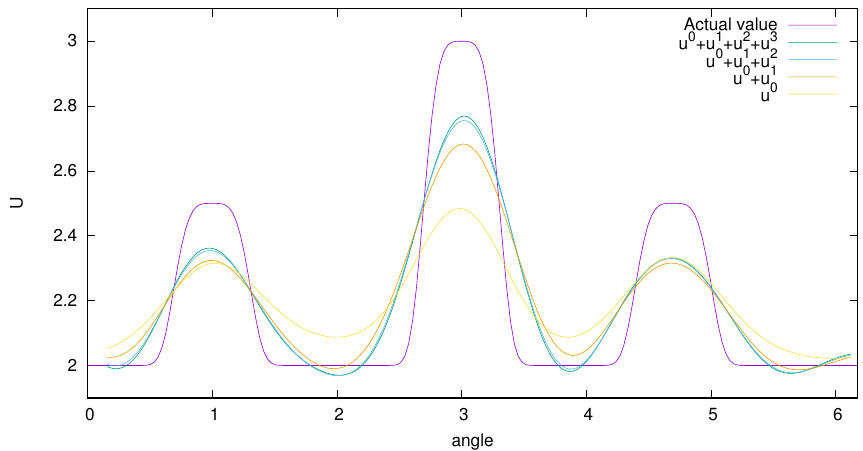
Figure 3. Recovered unknown interior boundary for the example 1 with 0.03%